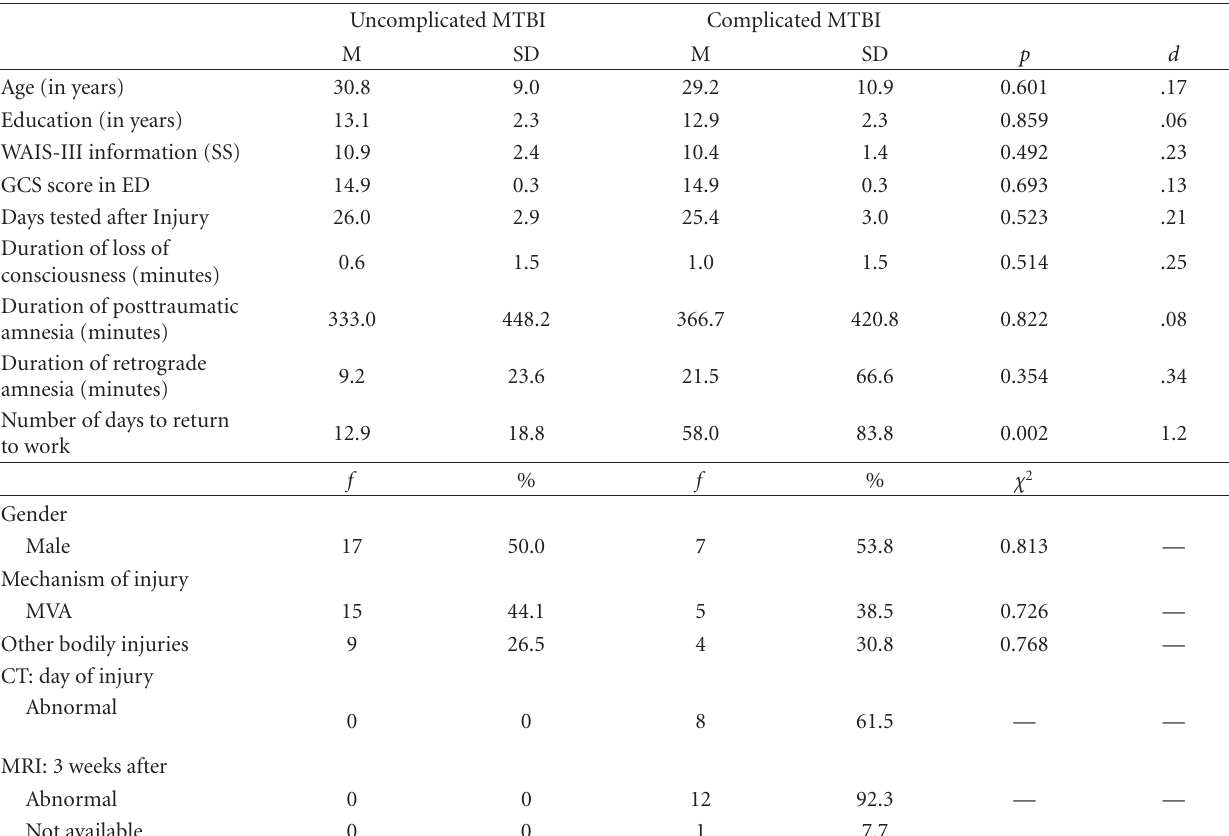
Table 2: Demographic and injury severity characteristics.